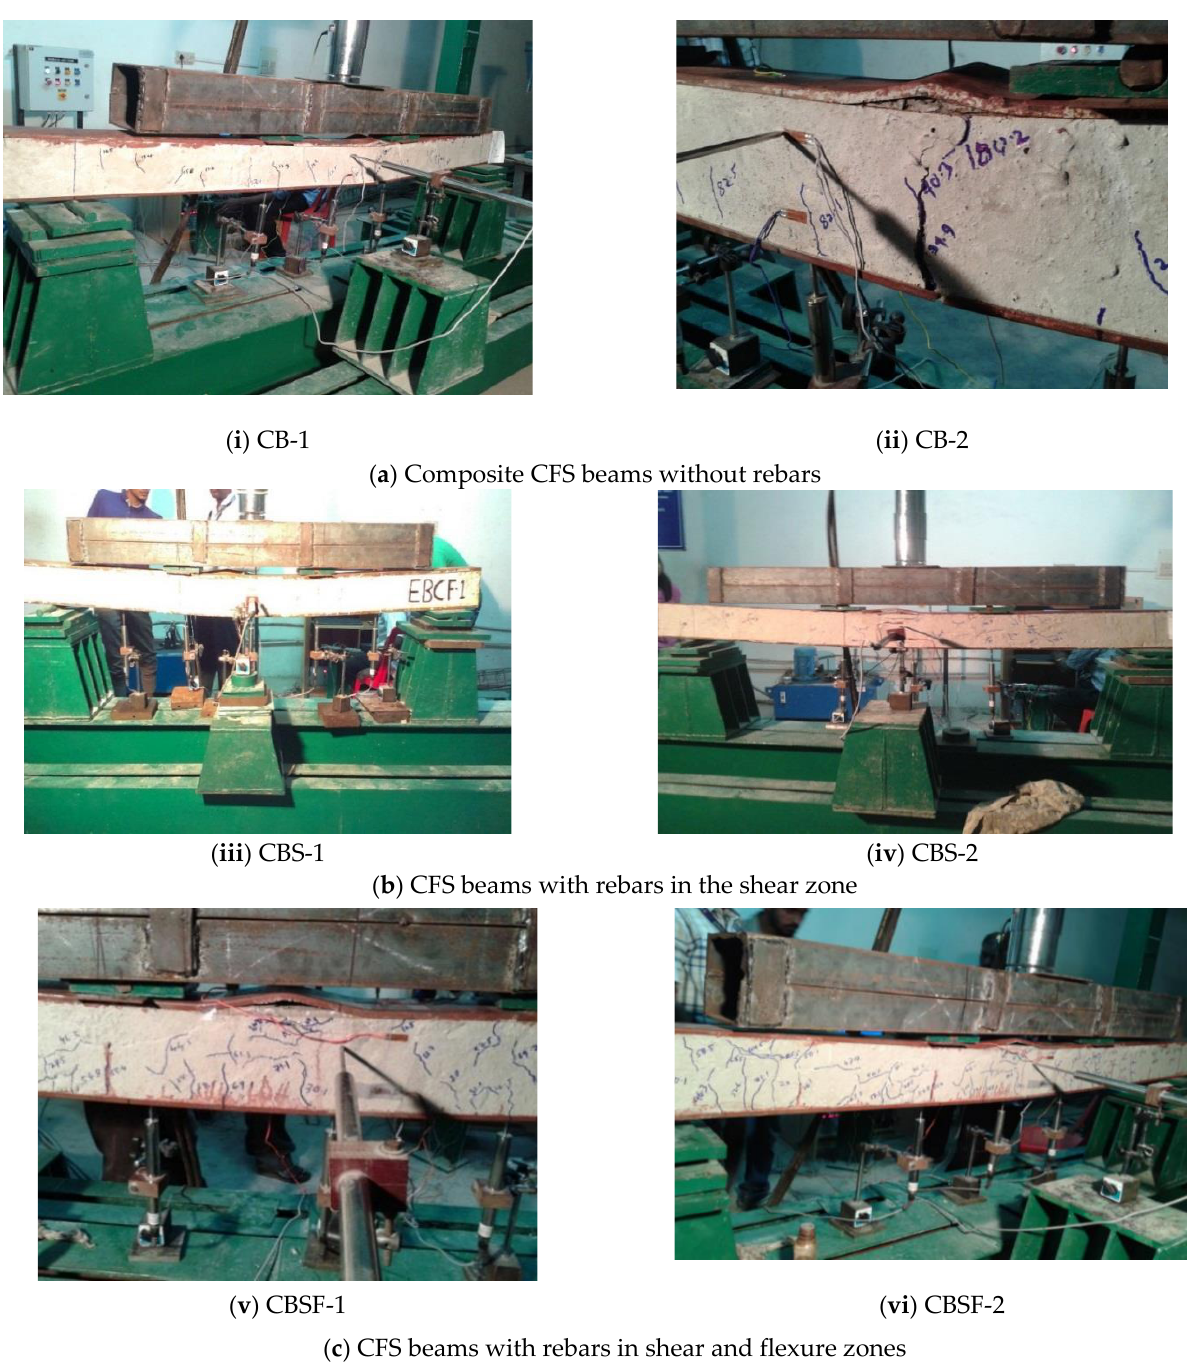
Figure 5. Failure of composite CFS beams.